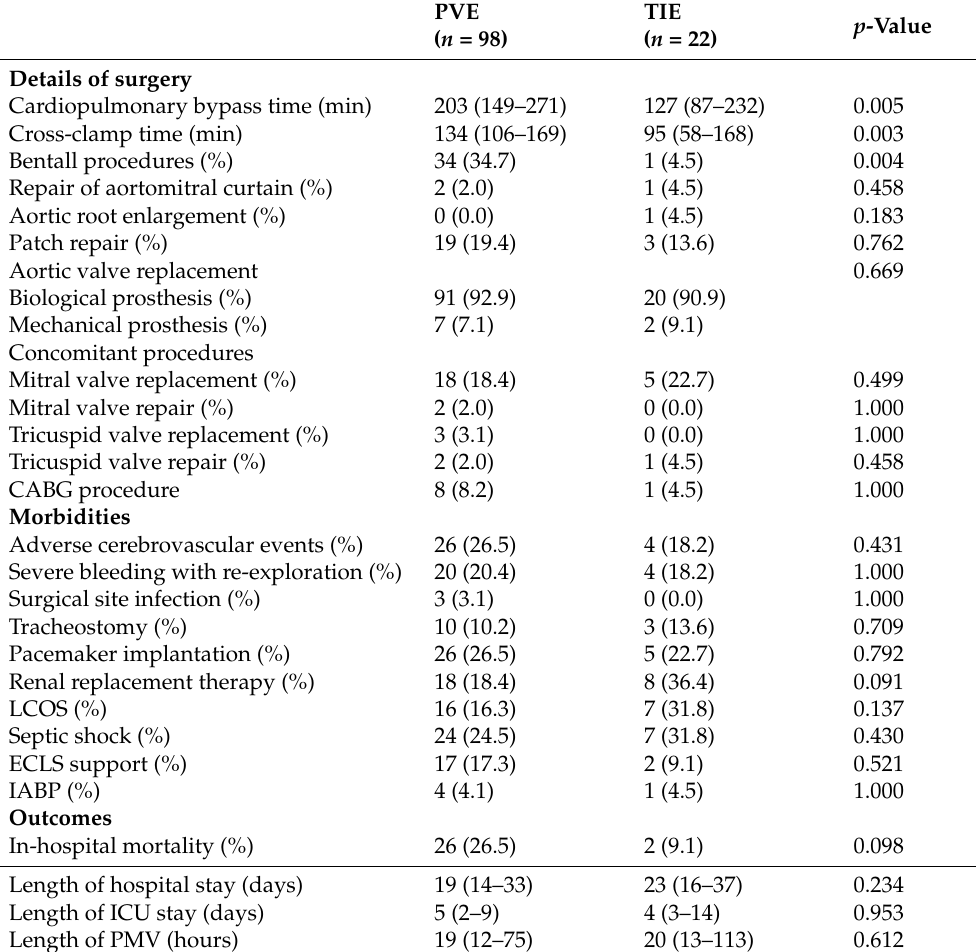
Table 5. Postoperative complications and outcomes. ECLS, extracorporeal life support; IABP, intra-aortic balloon pump; ICU, intensive care unit; LCOS, low cardiac output syndrome; PMV, postoperative mechanical